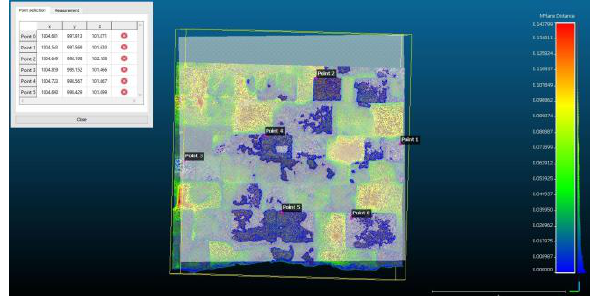
Figure 11 . qMplane Plugin: Defining the best fit plane by picking points on the 3D point